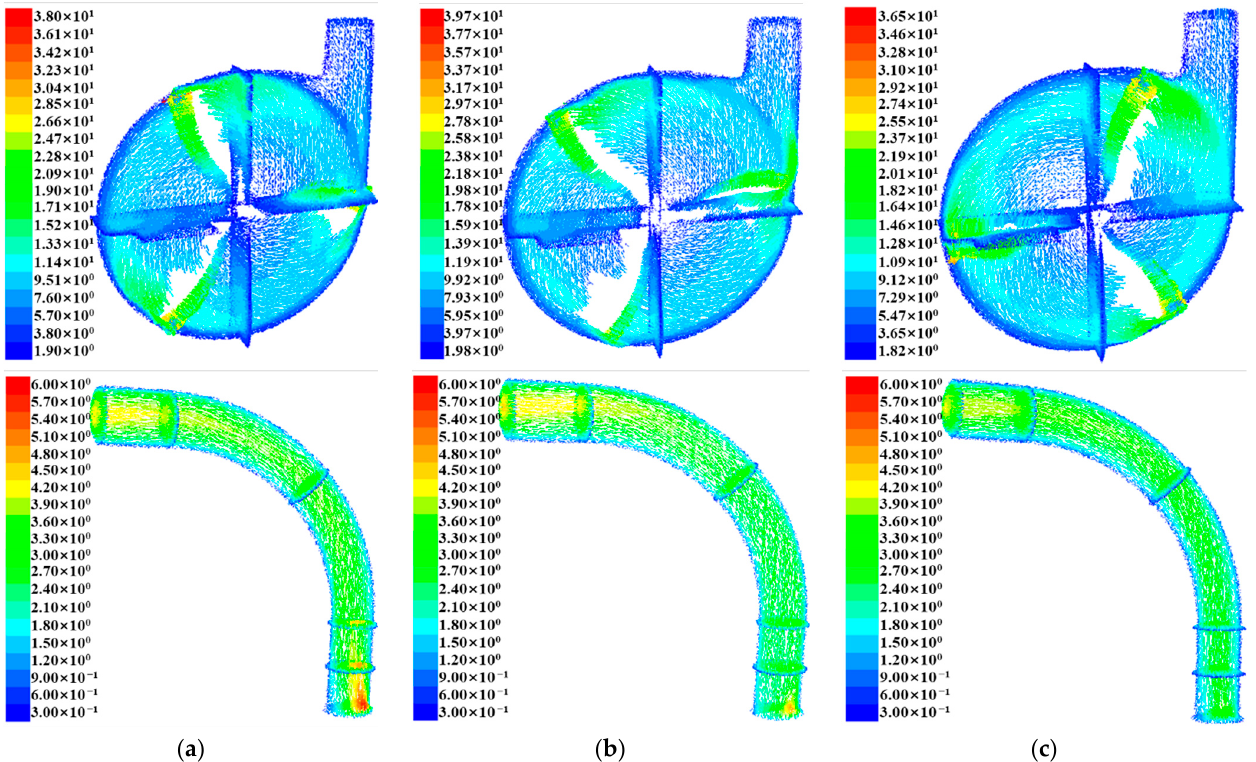
Figure 9. The velocity vector diagram of the material phase in the device with different blade incli- nation angles. ( a ) Blade inclination angle was 0°. ( b ) Blade was tilted back 15°. ( c ) Blade was tilted inclination angles. ( a ) Blade inclination angle was 0 ◦ . ( b ) Blade was tilted back 15 ◦ . ( c ) Blade was forward 15°. tilted forward 15 ◦